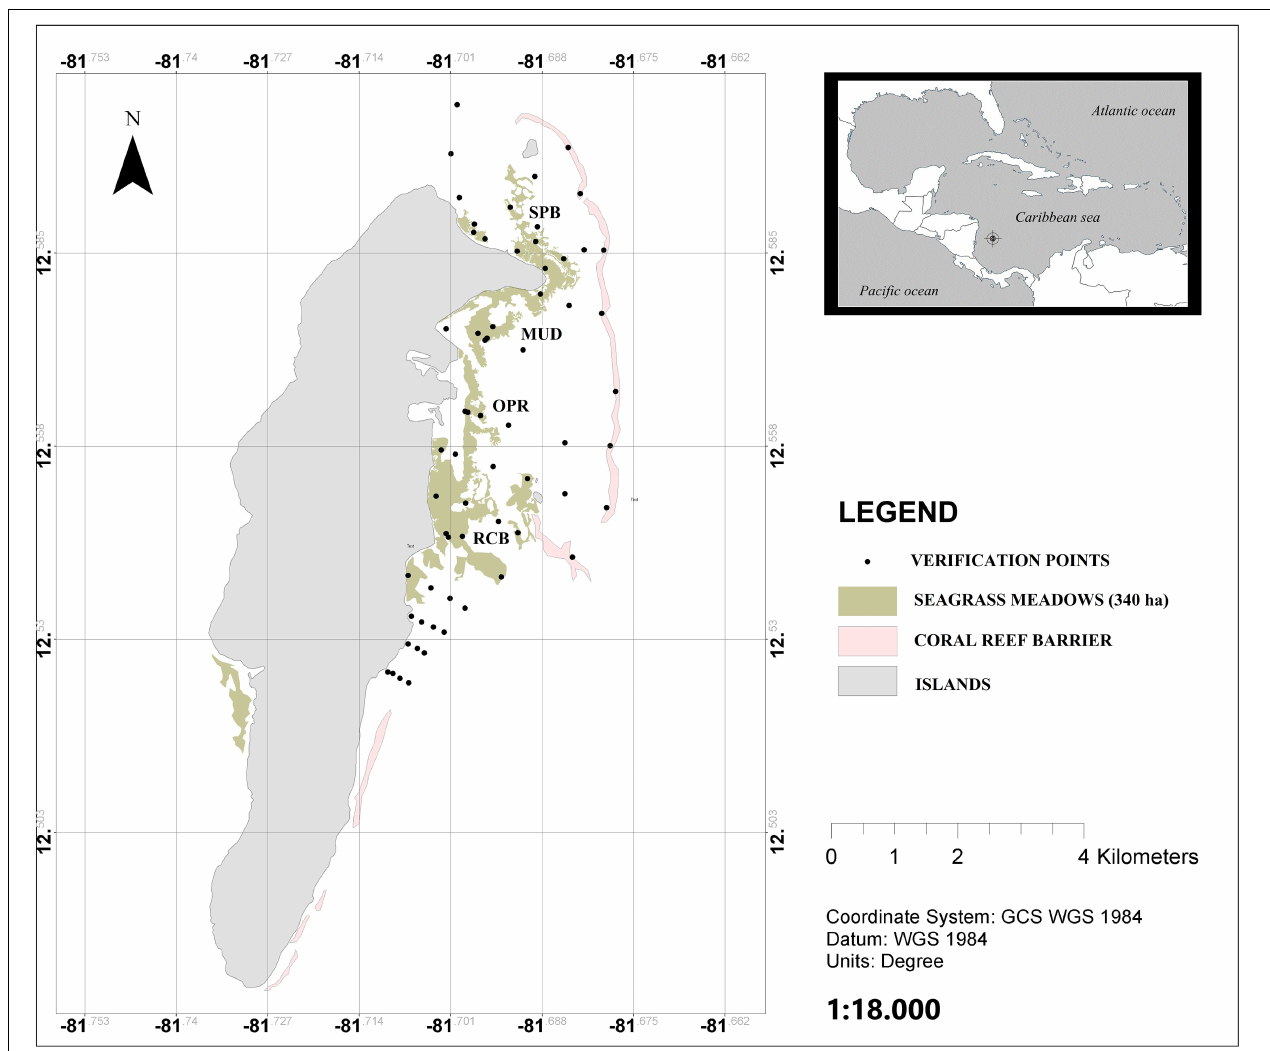
FIGURE 1 | Seagrass meadows in San Andrés island, mapped as green patches. The pink patches are the coral reef barriers. The black circles represent the sampling points used to verify seagrass cover. The four sampled locations are shown on the map; SPB, Sprat bay; MUD, in the island harbor; OPR, in the marine protected area of Old Point Regional Park of Mangrove; and RCB, at Rocky Cay bay. This figure was modified from Guerra-Vargas and Guerra-Vargas